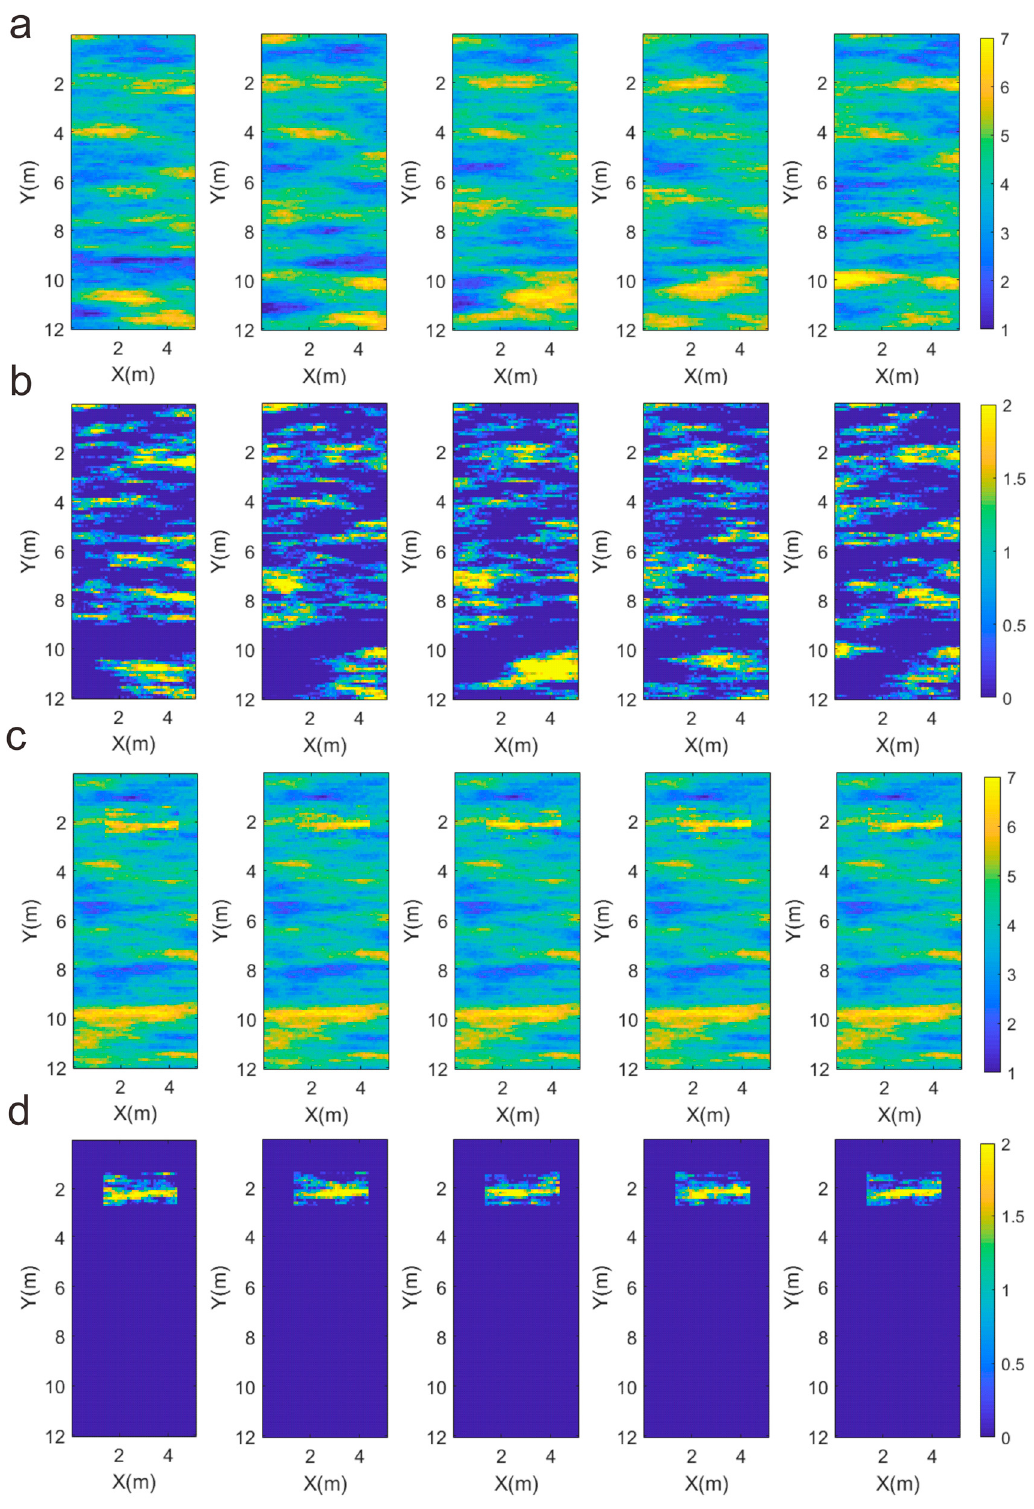
Figure 8. ( a ) Full sampling inversion model of T 2 , and ( b ) the perturbation of the full sampling inversion. ( c ) Local sampling inversion model of T 2 , and ( d ) the perturbation of the local sampling